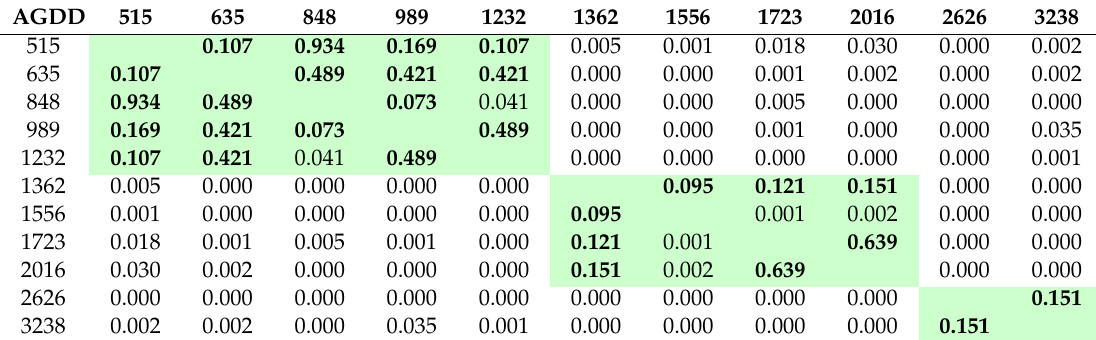
Table A2. p -values of significance test ( p < 0.05) for all observation dates of the NIR-RGB setting. Not significant di ff erences are marked in bold. The green color depicts the three temporal windows (i.e., early, medium and late) over the growing season.